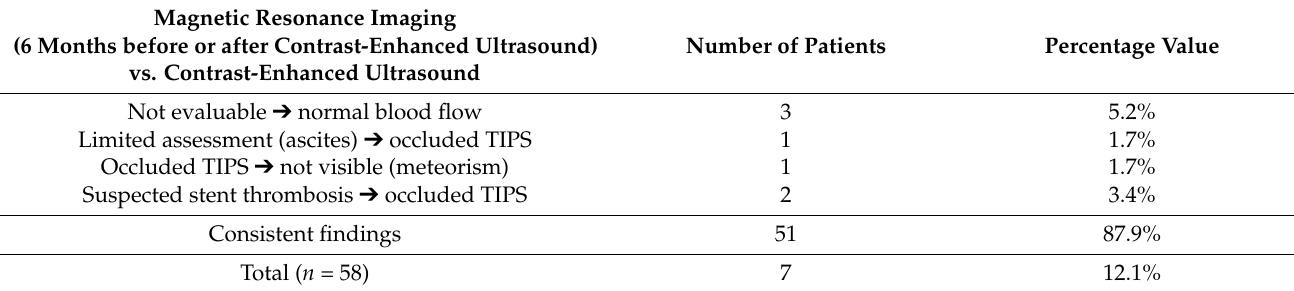
Table 6. Depiction of the different findings during Magnetic Resonance Imaging and contrast-enhanced ultrasound. Magnetic Resonance